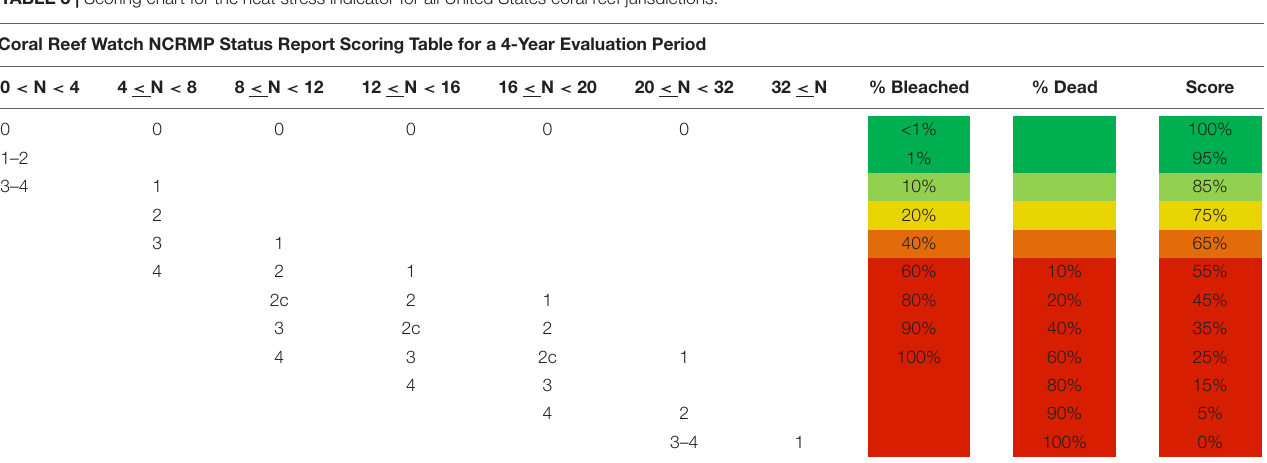
FIGURE 4 | Status report scoring for fish sustainability for the United States Pacific jurisdictions by region using mean size relative to a remote-location benchmark. TABLE 3 | Scoring chart for the heat stress indicator for all United States coral reef